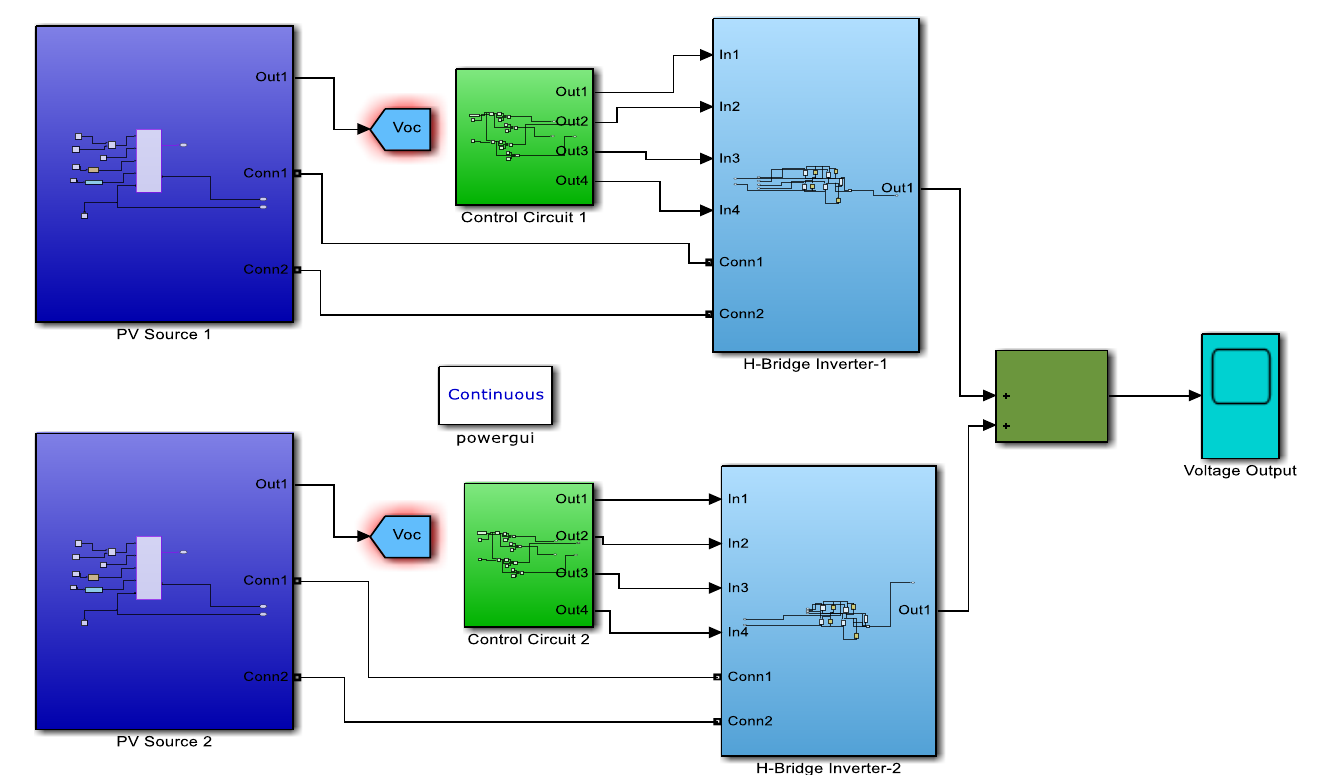
Figure 15. Cascaded 5-level CHB-MLI simulation model.